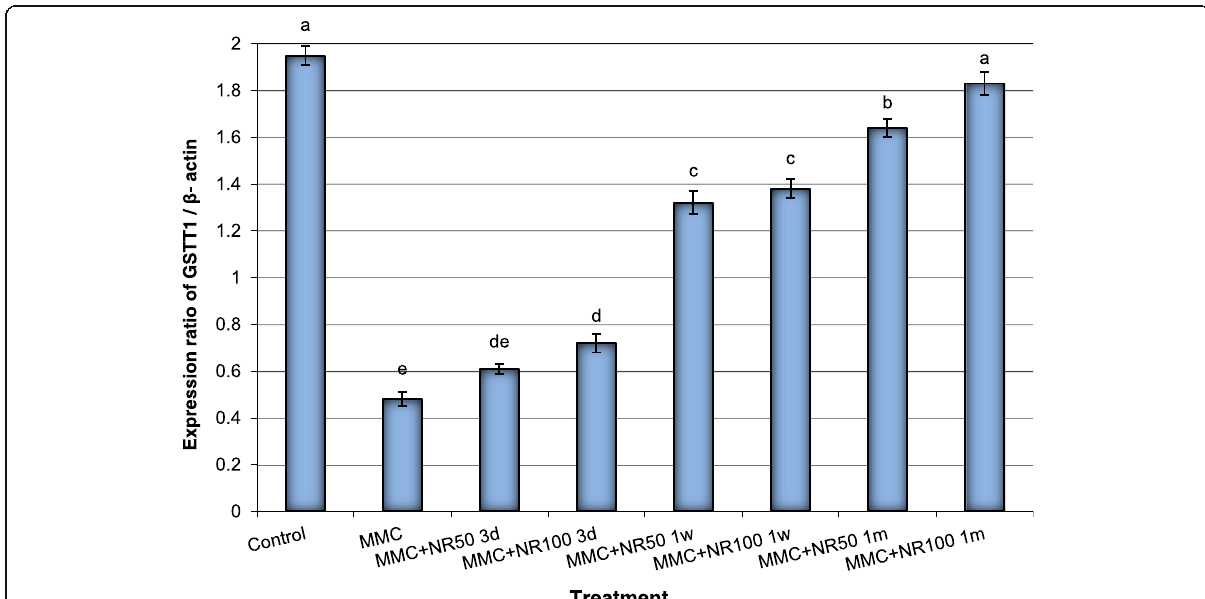
Fig. 3 Expression alteration of GSTT1 gene in liver tissues collected from MMC-treated mice supplemented with different doses (50 and 100 mg/ kg body wt) of Nitraria retusa leaf extracts at different time intervals (3 days, 1 week, and 1 month). Data are presented as mean ± SEM. a,b,c,d Mean values within tissue with unlike superscript letters were significantly different ( a P < 0.01, b,c,d P <